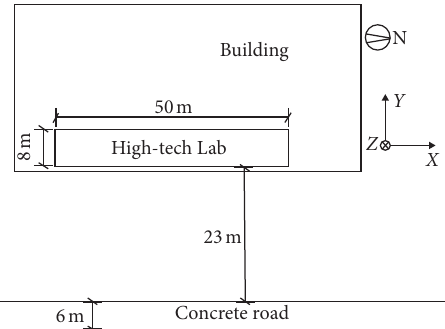
Figure 2: Layout of the high-tech lab and road.